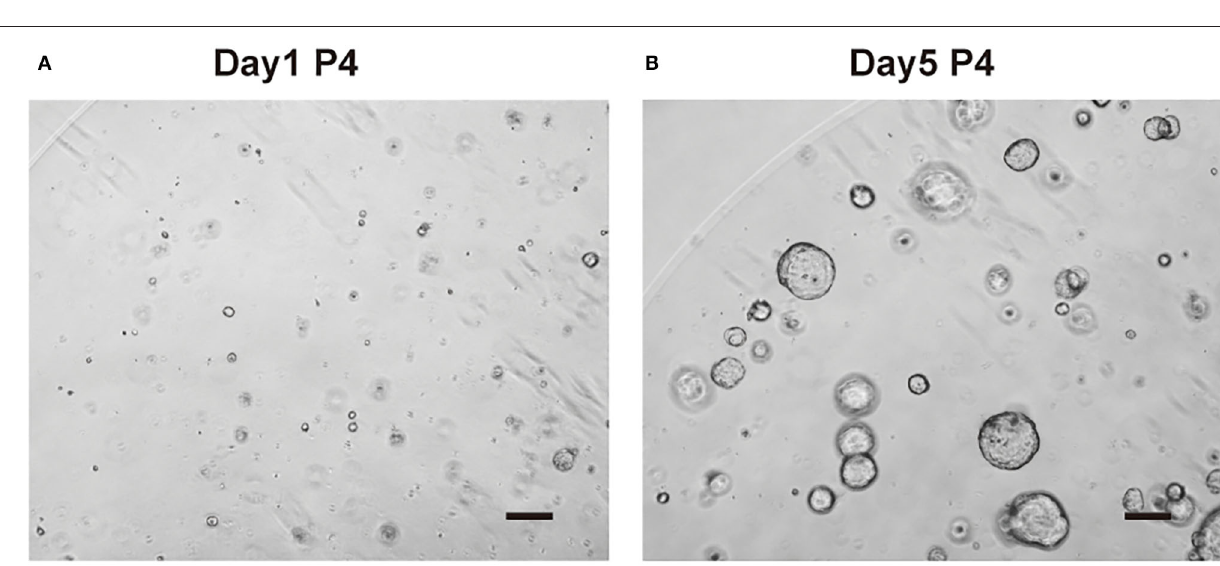
FIGURE 6 | Organoid culture after thawing. (A) Cholangiocytes-organoids (cho-orgs) were cultured for 1 day after thawing (bar, 200 µ m) (P4, passage 4). (B) Cho-orgs are cultured for 5 days after thawing (bar, 200 µ